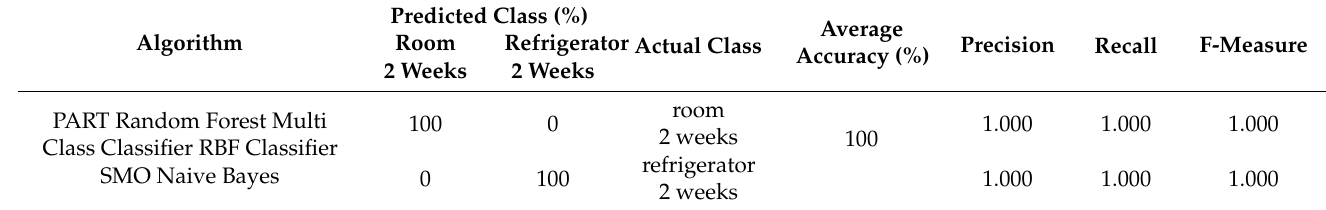
Table 4. The confusion matrices, average accuracies and the values of Precision, Recall and F-Measure of the classification of red currants stored at room temperature for two weeks and stored in the refrigerator for two weeks for models including selected textures from color channels R , G , B , L , a , b , X , Y , and Z